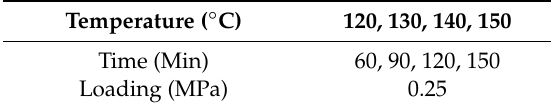
Figure 2. ( a ) Concept illustration of the crosslinking process and ( b ) images of the sulfated fibers under loads of 0, 0.25 and 0.5 MPa for the precursor fibers. Table 1. Sulfuric acid treatment conditions of LDPE/HDPE sheath-core fiber.